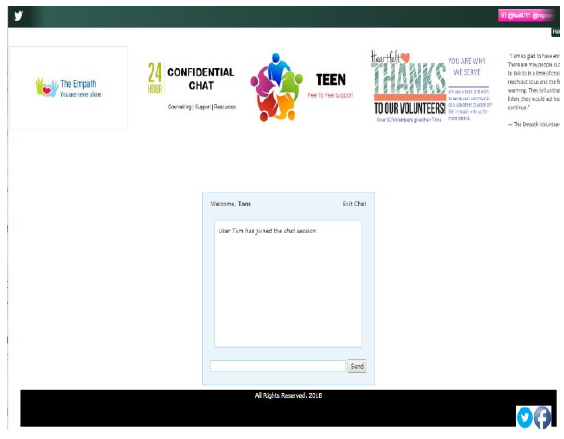
Figure 15. Counsellor pairing with a Client